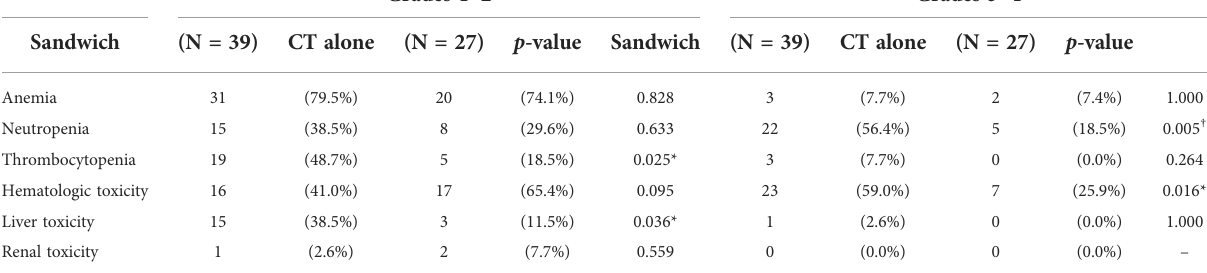
TABLE 3 Adverse